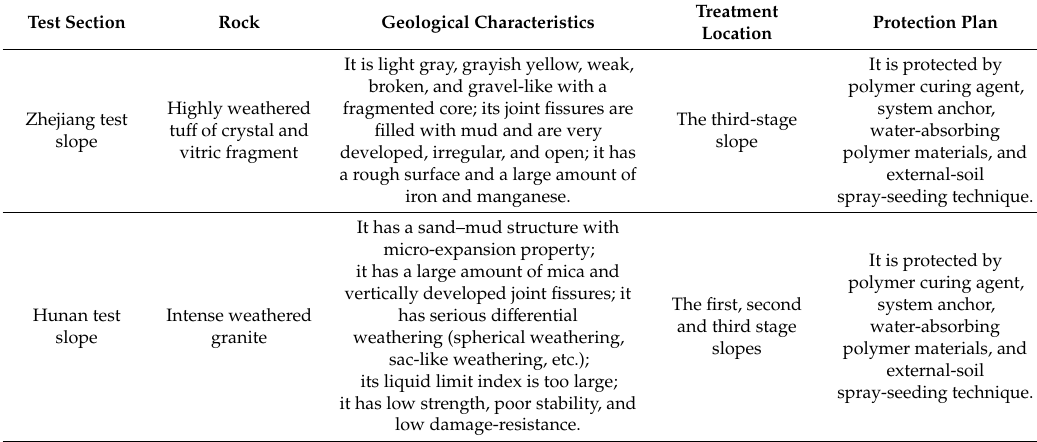
Table 6. Protection design of the test slope.